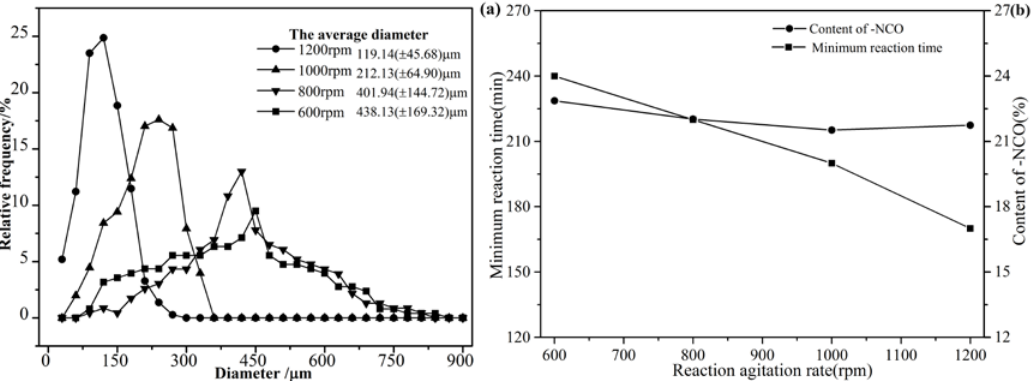
Figure 3. The diameter ( a ), minimum reaction time and –NCO content ( b ) with different agitation rates.